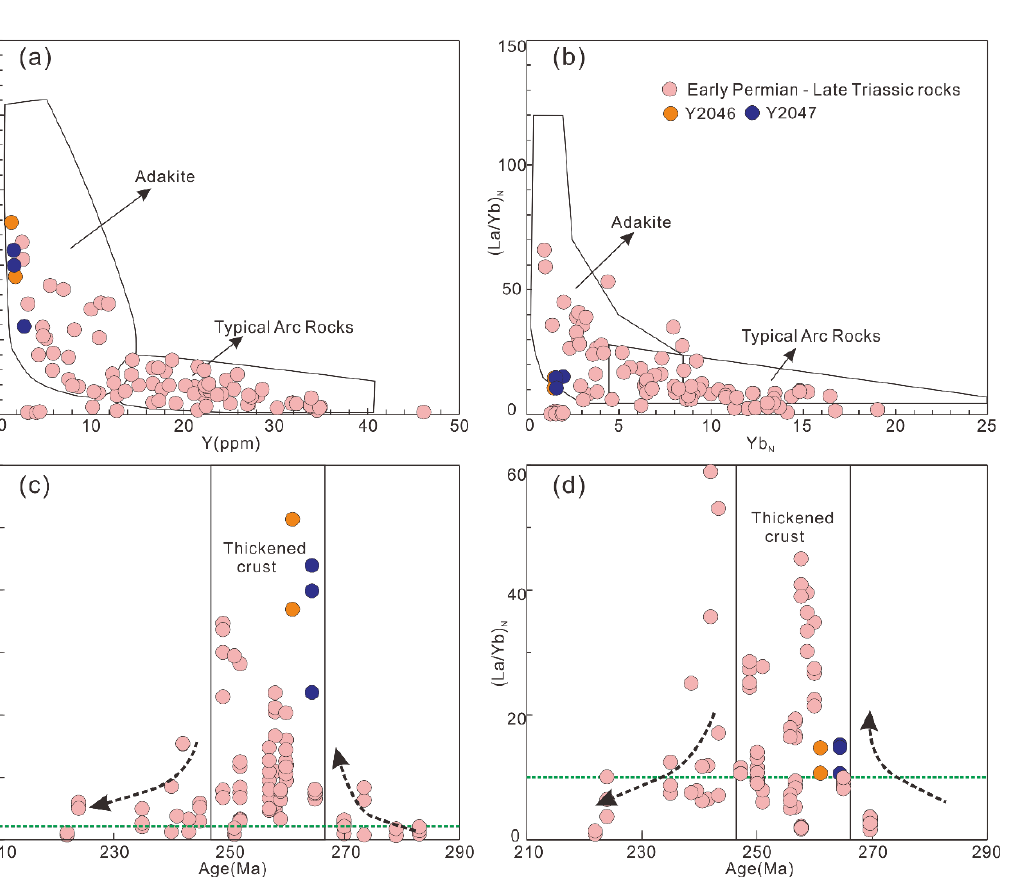
Figure 11. Sr/Y vs. Y ( a ), (La/Yb) N vs. (Yb) N ( b ), Sr/Y vs. Age ( c ), (La/Yb) N vs. Age ( d ), for the Middle Permian granites (after [63,64]). Data are from [30,35,36].